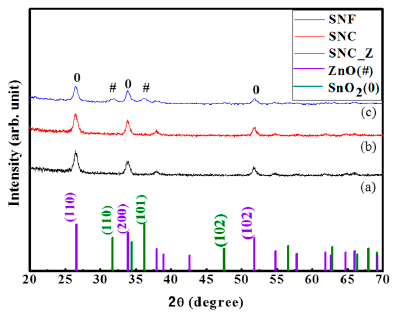
Figure 3. X ‐ ray diffractometer (XRD) patterns of ( a ) SnO 2 nanoparticle (SNP); ( b ) SnO 2 nanoflower (SNF); and ( c ) SNC_Z (1:1) samples.